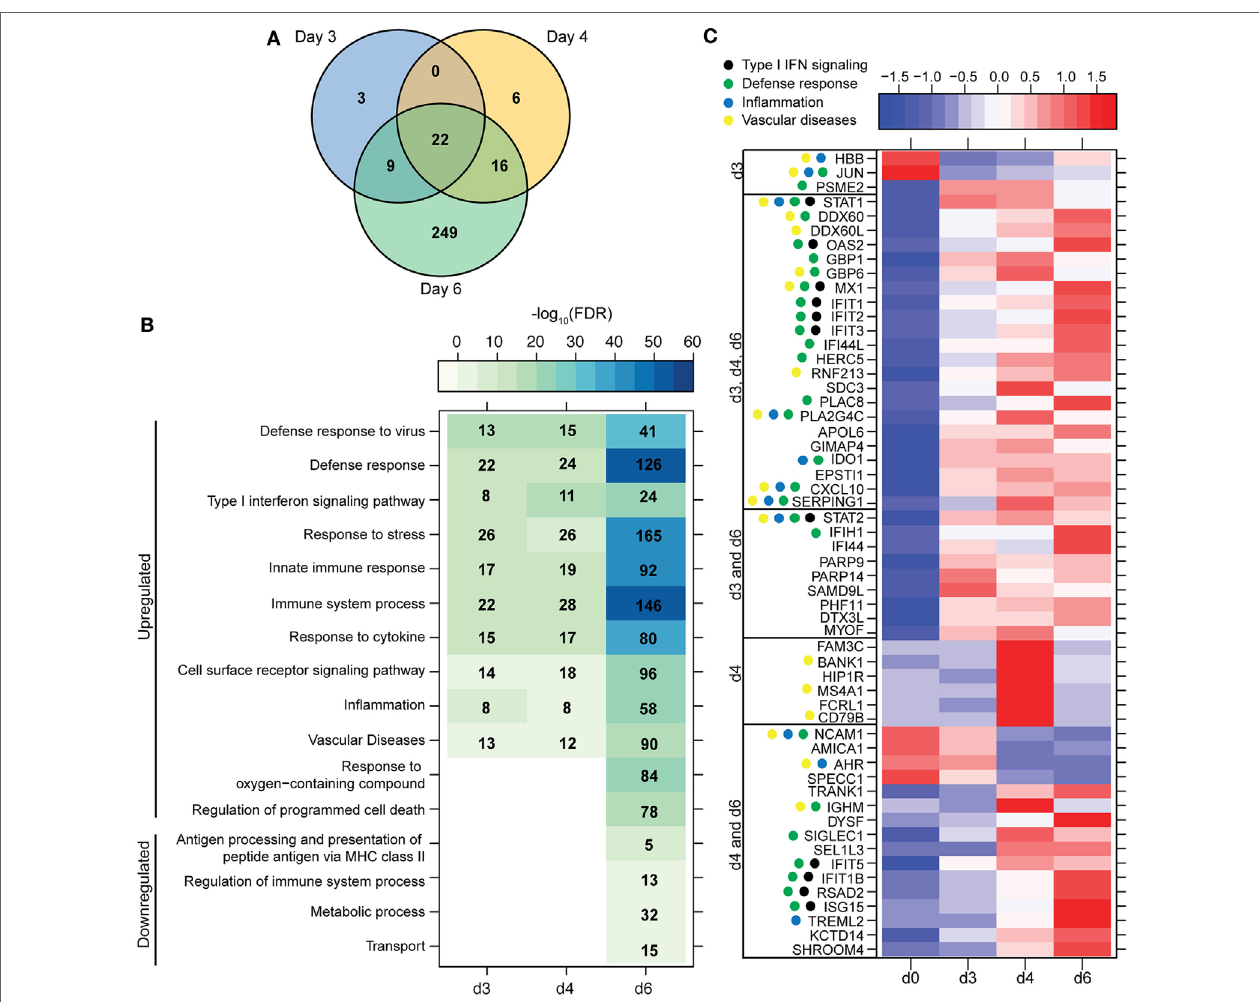
FigUre 2 | ZEBOV-Makona infection induces expression of genes involved in defense response and Type I IFN signaling in monocytes. (a) 3 way Venn diagram displaying overlap between differentially expressed genes (DEGs) detected 3, 4, and 6 DPI in purified monocytes. (B) Heatmap representing functional enrichment of DEGs 3, 4, and 6 DPI; color intensity represents the statistical significance (shown as negative log 10 of the false discovery rate (FDR)-corrected p -value); range of colors is based on the lowest and highest –log 10 (FDR) values for the entire set of terms; the number of DEGs mapping to each functional enrichment term each day is listed within each box; blank boxes represent no statistical significance. (c) Heatmap representing gene expression (shown as absolute normalized RPKM values) of all DEGs detected 3 and 4 DPI; genes enriching to Gene Ontology or disease term are indicated by colored dot; range of colors is based on scaled and centered RPKM values of the entire set of genes (red represents increased expression while blue represents decreased expression); each column represents the median RPKM values for each